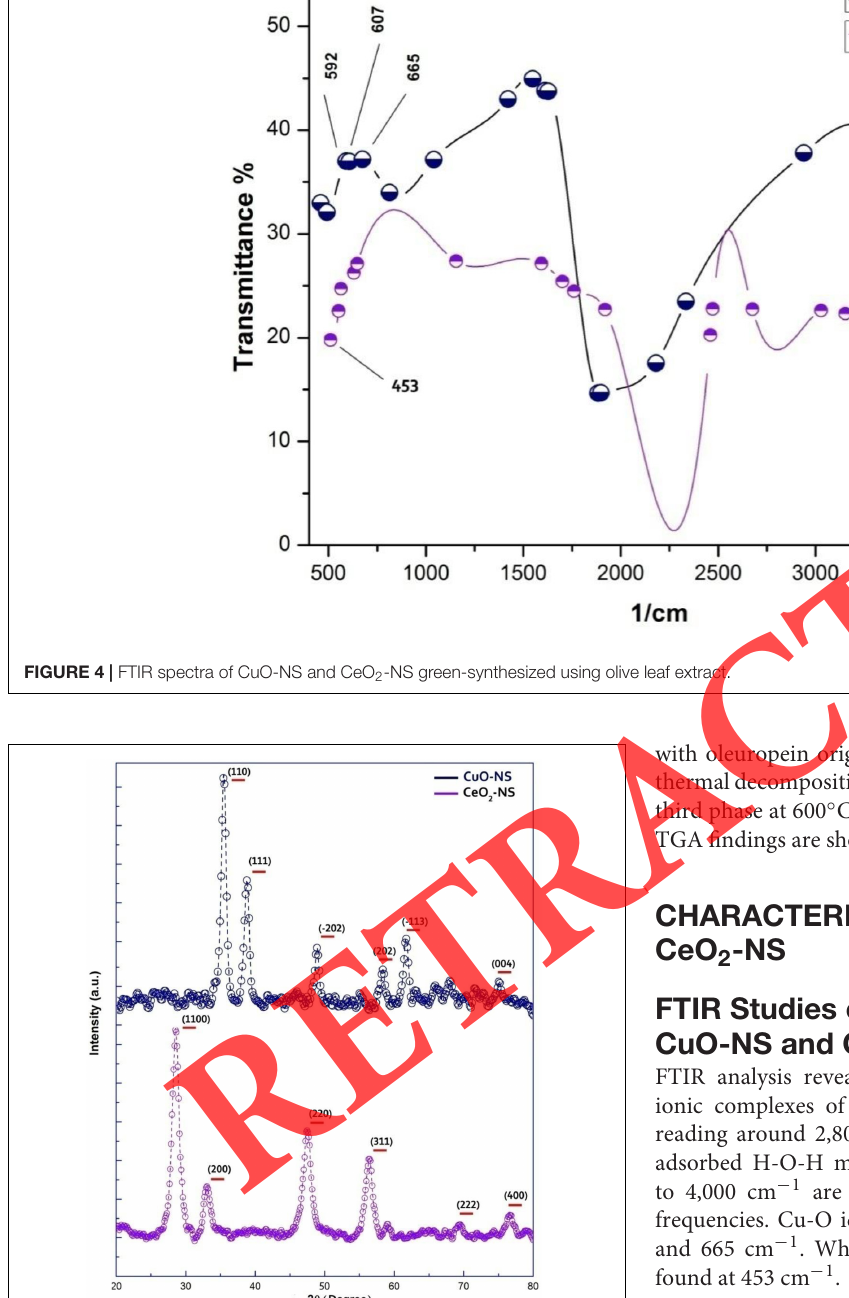
weight in NS was observed in three phases. In the first phase from 50 to 100 ◦ C, the loss of weight was due to surface absorbed H 2